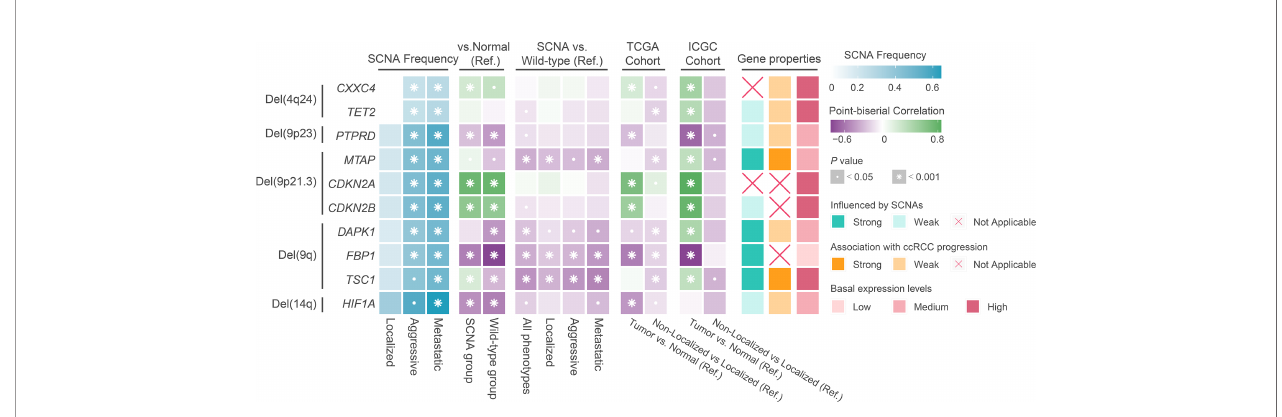
FIGURE 4 | The result of transcriptional regulatory relationship between SCNAs and target genes. Ref: Reference